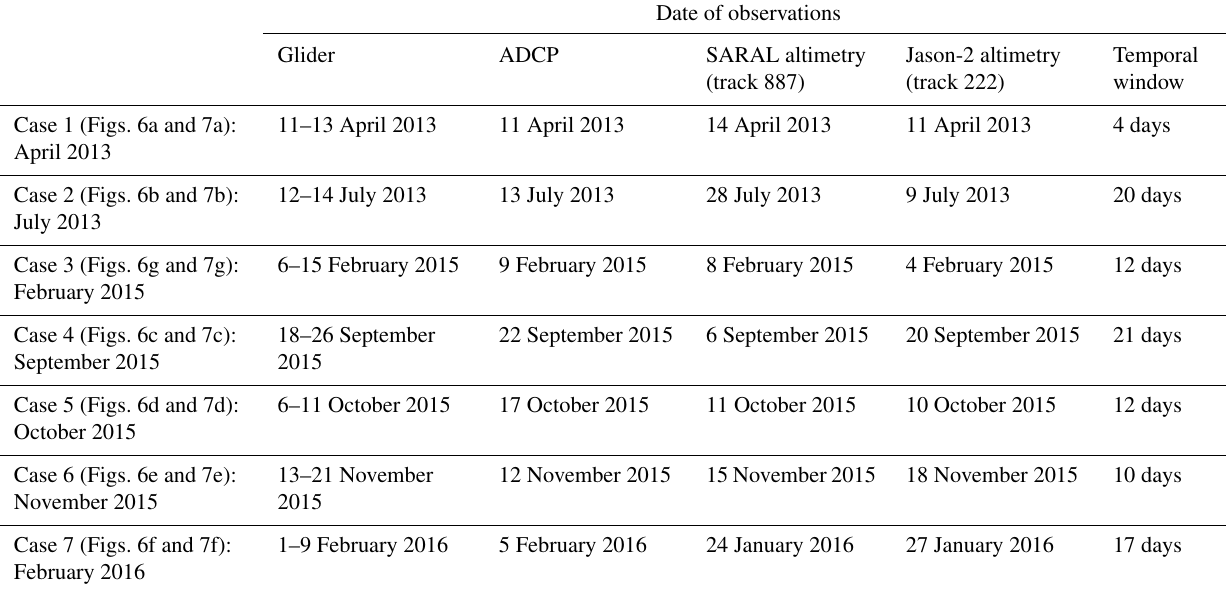
Table 3. List of the cases of relative co-localization in time between the glider, ADCP and altimetry current data, with the corresponding dates of